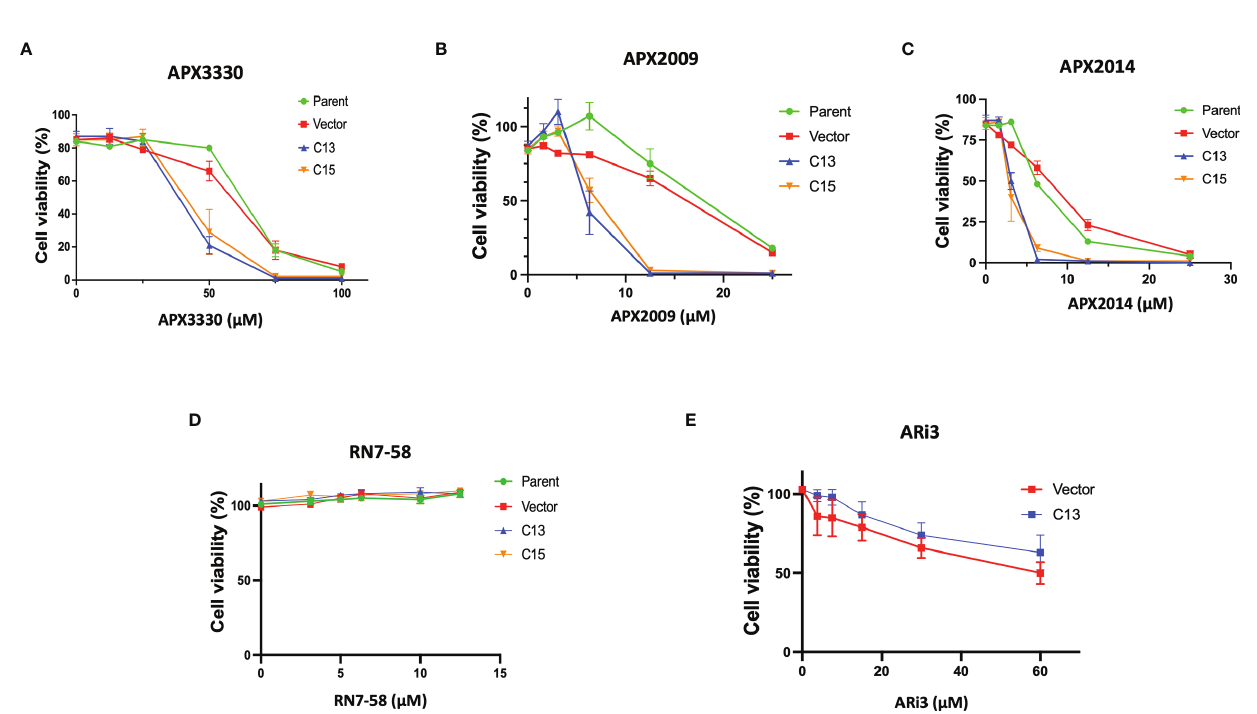
FIGURE 1 | Re-expression of RelA renders tumor cells sensitive to Ref-1 inhibitors. KC3590 cells that underwent functional deletion of RelA (Parent and Vector) and KC3590 clone lines that express functional RelA (C13, C15) were challenged with different concentrations of APX3330 (A) , APX2009 (B) and APX2014 (C) , RN7-58 (D) , ARi3 (E) for 48 hours. Cytotoxicity was measured by Alamar blue (4 hr incubation) at 590 nm. Error bars represent standard error (N = 3). Statistical differences between EC 50 s of Ref-1 inhibitors in KC3590 cells are provided in Table 1